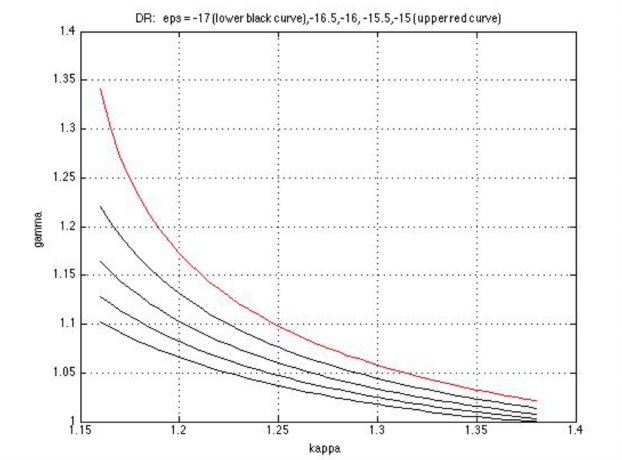
Figure 10: Plots of γ 2 = γ 2 ( κ ) solving DE (9) for a higher- order DR surface modes at (cid:15) = − 15 − 0 . 5 k from k = 0 (upper red curve) to k = 4 (lower black curve) correspond- ing to greater (right) intersection points of F d ( γ ) and G d ( γ ) in Fig. 6.